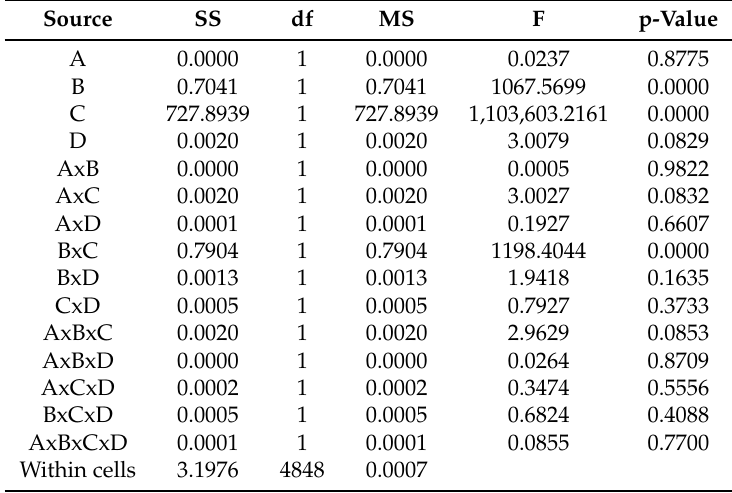
Table A1. Four-way ANOVA table for the expected accuracy